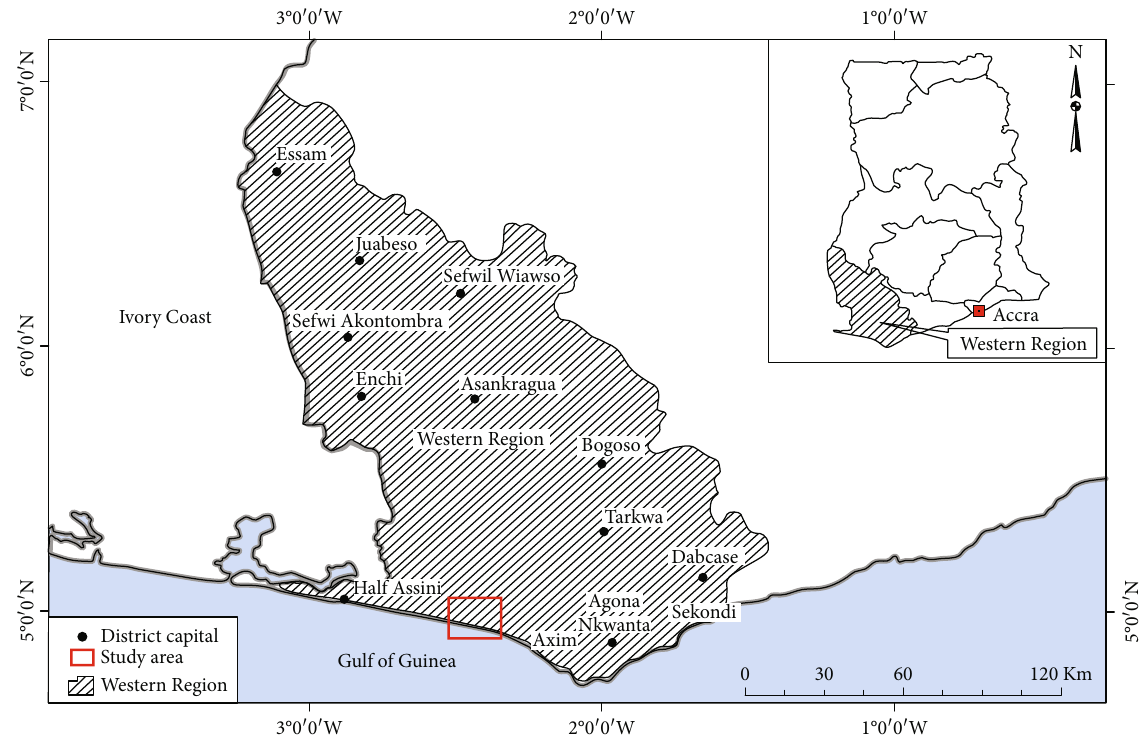
Figure 1: Map of the Western